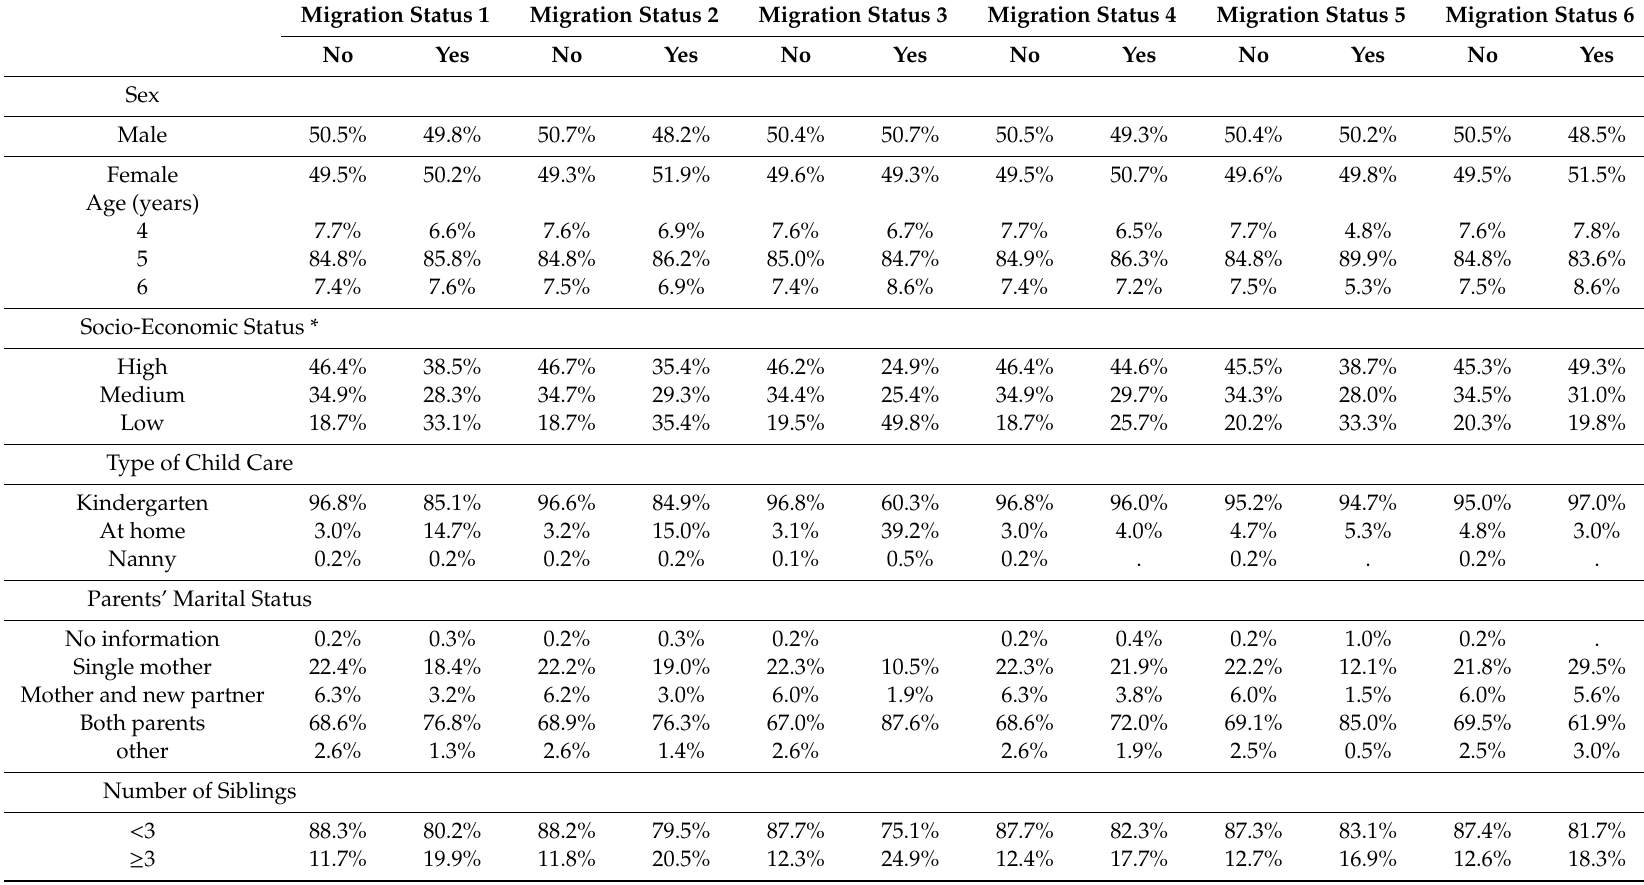
Table 1. Socio-demographic characteristics of the study